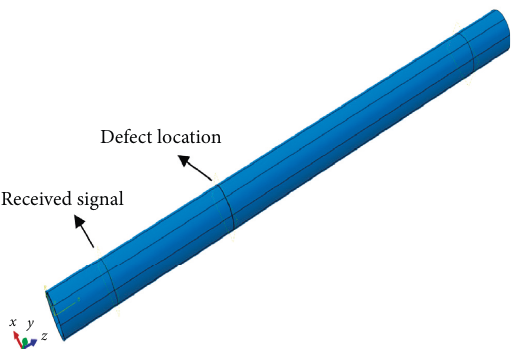
Figure 4: Defective straight pipe finite element model.